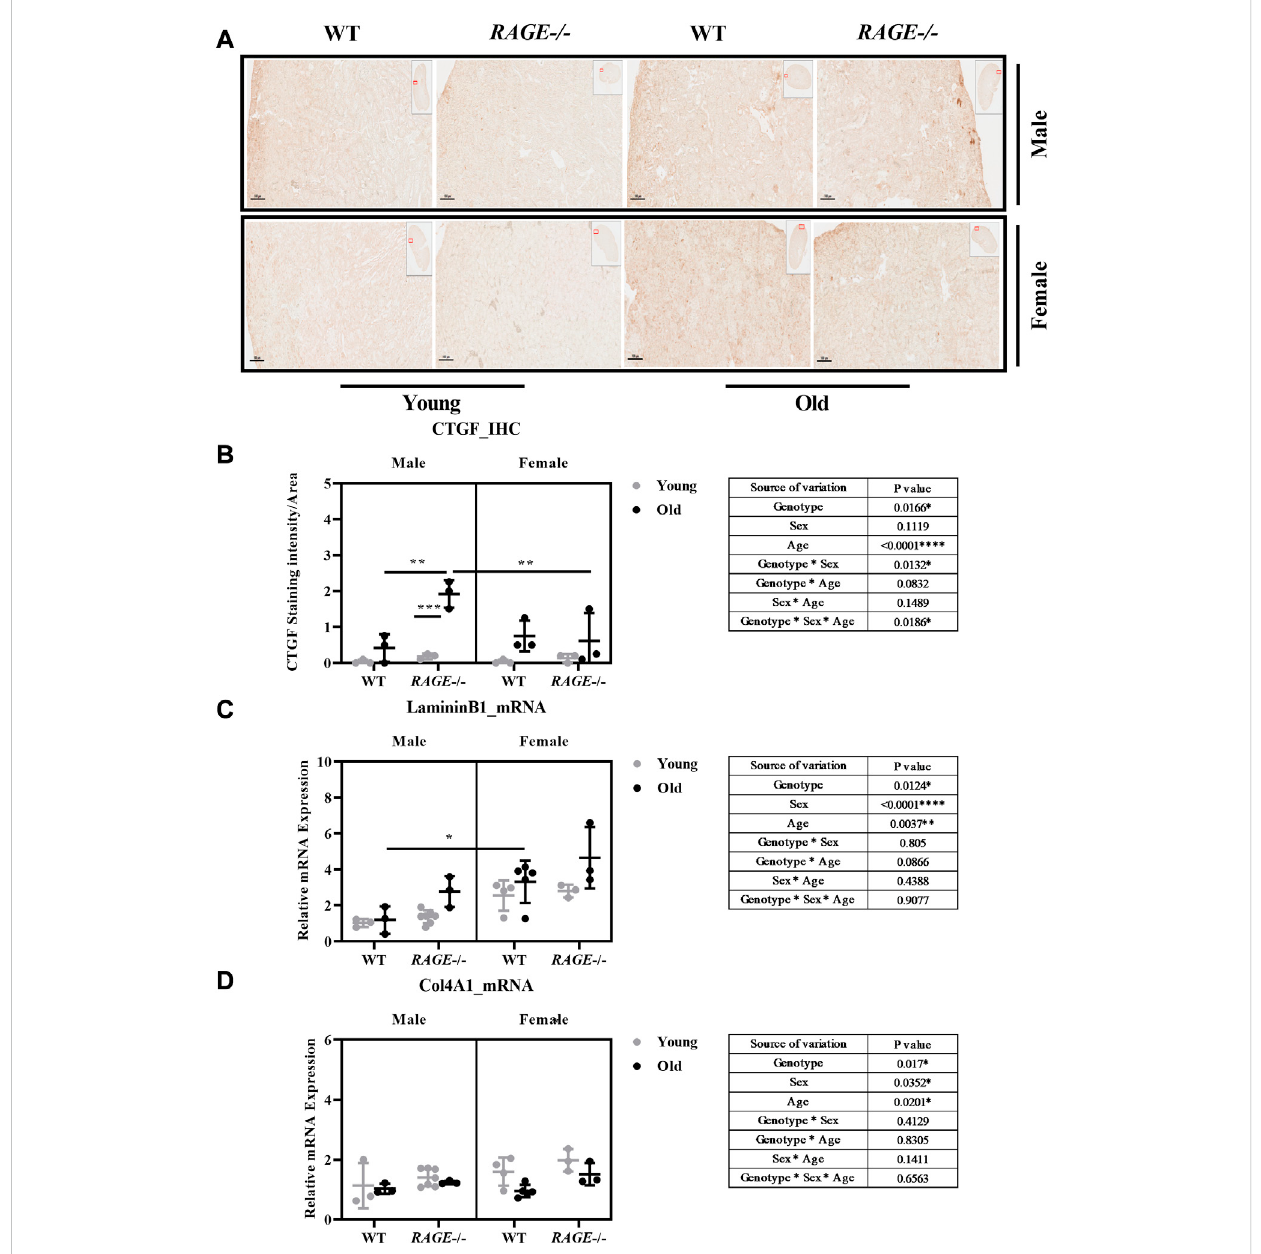
FIGURE 7 Quanti fi cationofkidney fi brosis: (A) representativeimagesofCTGF immunohistochemistryinkidney sections fromtheindicatedgenotypes. Brown area indicates CTGF staining and (B) quanti fi cation of CTGF staining intensity. mRNA quanti fi cation by q-PCR for (C) laminin B1 and (D) Col4A1 . Signi fi cance and interaction were calculated by three-way ANOVA with genotype (wild type vs RAGE − / − , sex (male vs. female), and age (young vs. old) as three factors (shown in table insert). Sidak multiple comparisons tests were performed for intergroup signi fi cance (shown above bars). Young ( < 30 weeks) and old ( > 70 weeks) male and female mice ( n = 3 – 7) were used in the experiment. Images were taken under ×100 magni fi cation. Data are shown as mean ± SD; p- value : 0.05*, 0.01**, 0.001***, and